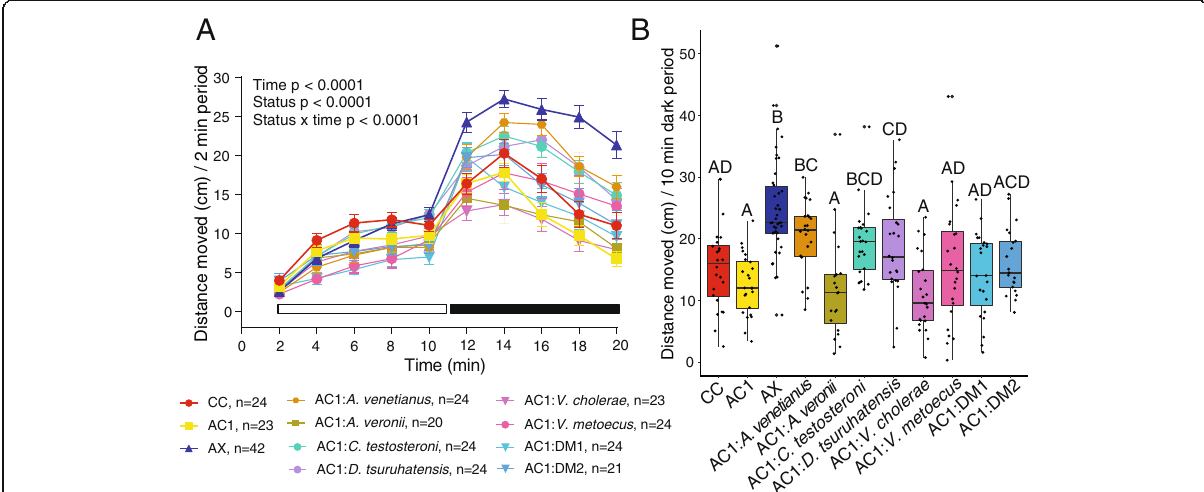
Fig. 2 Association with select host-associated bacterial species variably blocked the hyperactive axenic behavioral phenotype ( n =4 – 8 larvae per flask from 3 to 7 flasks per cohort). Distance moved every 2min in the light and dark periods ( a ; error bars=standard error of the mean) and mean distance moved every 10min in the dark period ( b ). Different letters indicate significant differences ( p <0.05). CC=conventionally colonized; AC1=axenic colonized on day 1; AX=axenic; AC1:DM1= A. venetianus + V. metoecus + C. testosteroni + D. tsuruhatensis+A. veronii ; AC1:DM2= A. venetianus + C. testosteroni + D. tsuruhatensis+A.